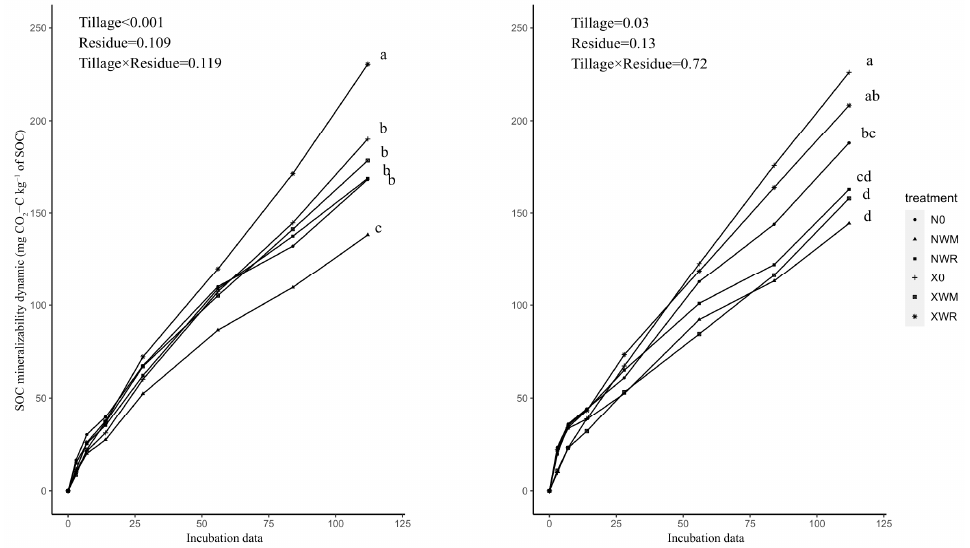
Figure 2. Figure 2. SOC mineralizability dynamics under different practices at 0–10 and 10–20 cm in the field soil experiments (without straw addition). N0: no-tillage with no straw returning; NWR: no-tillage with wheat straw returning; NWM: no-tillage with maize and wheat straw returning; X0: rotary tillage with no straw returning; XWR: rotary tillage with wheat straw returning; XWM: rotary tillage with maize and wheat straw returning. Lower case letters indicate significant differences ( p < 0.05) among treatments within the same soil